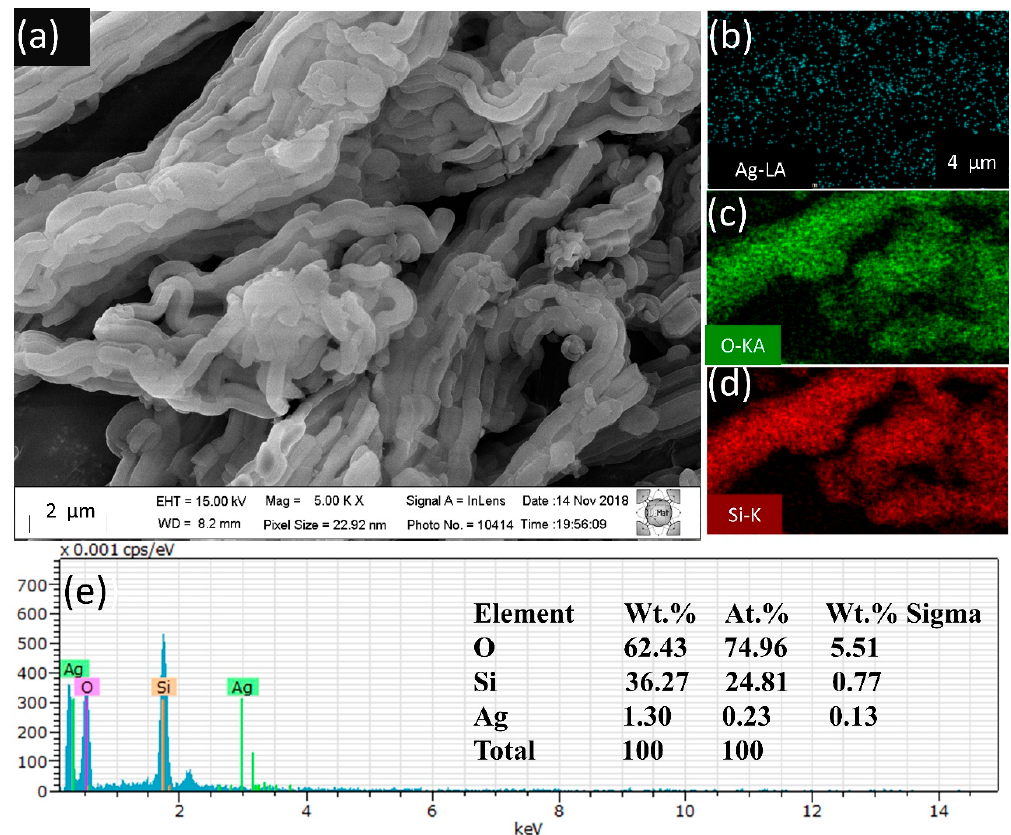
Figure 4. ( a ) Field-emission scanning electron microscopy (FESEM); ( b – d ) elemental mapping and ( e ) EDX spectrum obtained for 2AgSBA-15.